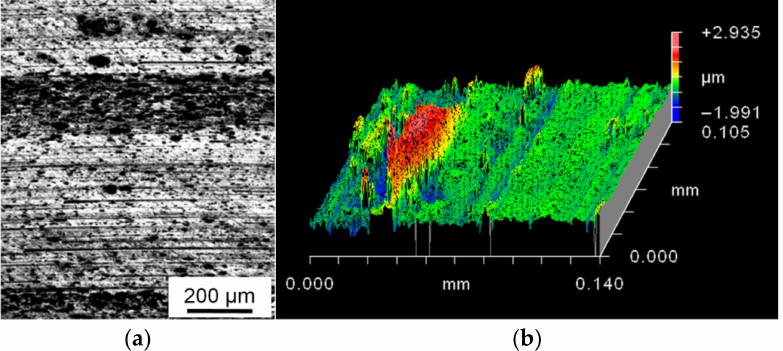
Figure 8. Optical image of the friction track surface on steel counterbody ( a ) and its profile obtained using scanning interference microscope ( b ). L = 1000 m, P = 1 MPa, V = 0.6